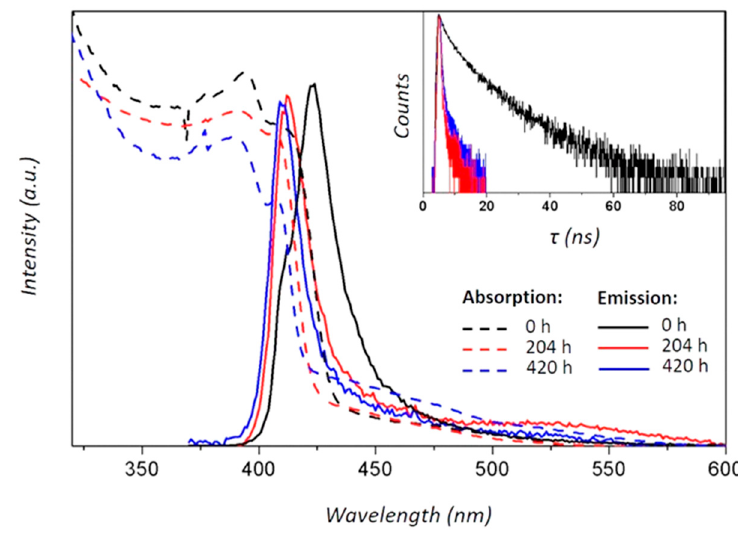
Figure 6. Absorption and steady-state emission photoluminescence (PL) spectra of as-prepared (0 h) PEA 2 PbI 4 , and that after 204 and 420 h of ball-milling (main panel). Time-resolved PL spectra (inset) of the same samples.